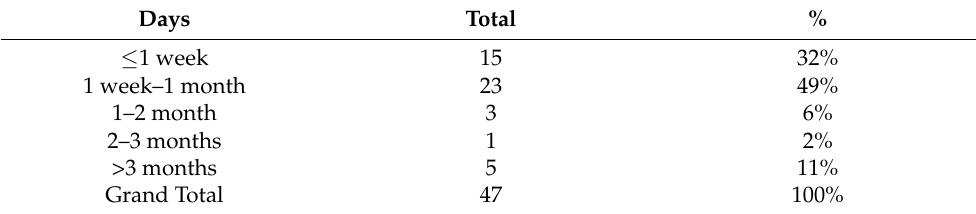
Table 5. Duration of contact isolation